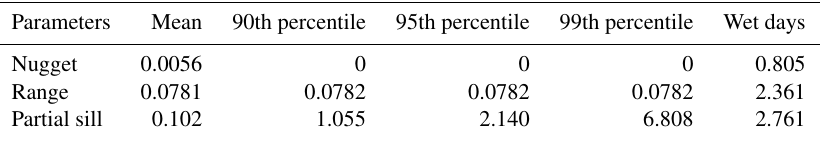
Table B1. Parameter values for the fitted